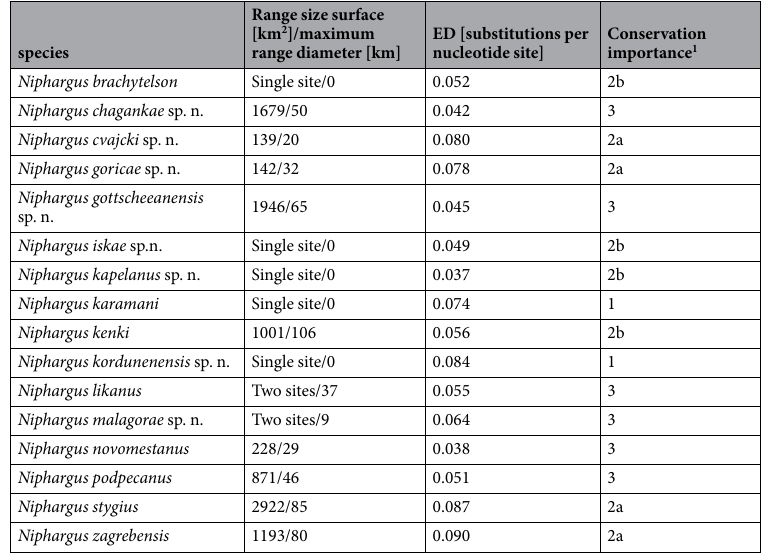
Table 1. Range sizes, evolutionary distinctness (ED), and estimated conservation importance of members of the N. stygius species complex. Range sizes are given as km2 or as maximal linear distance of the range to make data compliant with IUCN Red List 31 and the rest of publications from subterranean biology, respectively. 1 Conservation ranks are defined as follows: (1) high endemism and ED; (2a) low endemism, high ED, (2b) high endemism, low ED; (3) low endemism and ED.